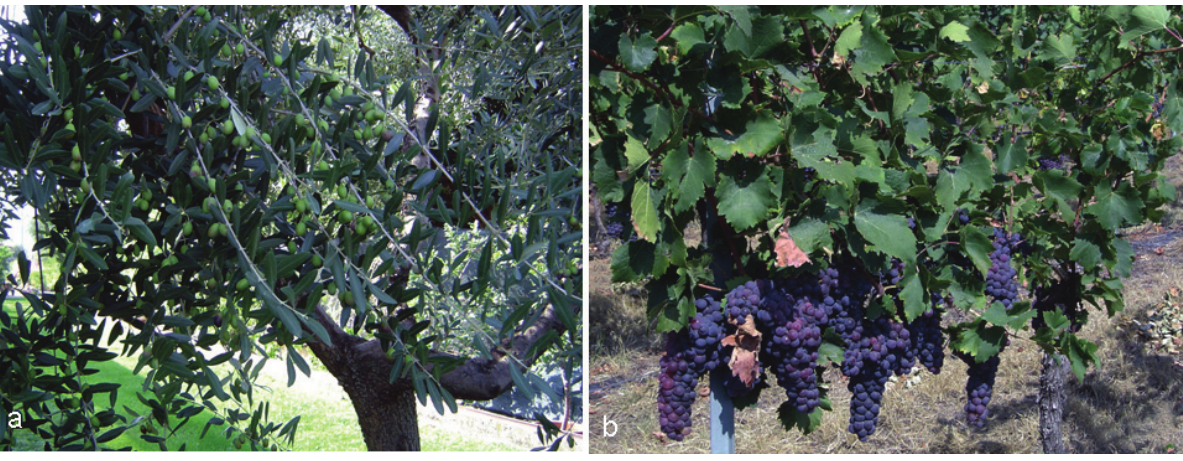
Figure 9. Traditional Mediterranean cultivations: Olea europea L. (a) and Vitis vinifera L.